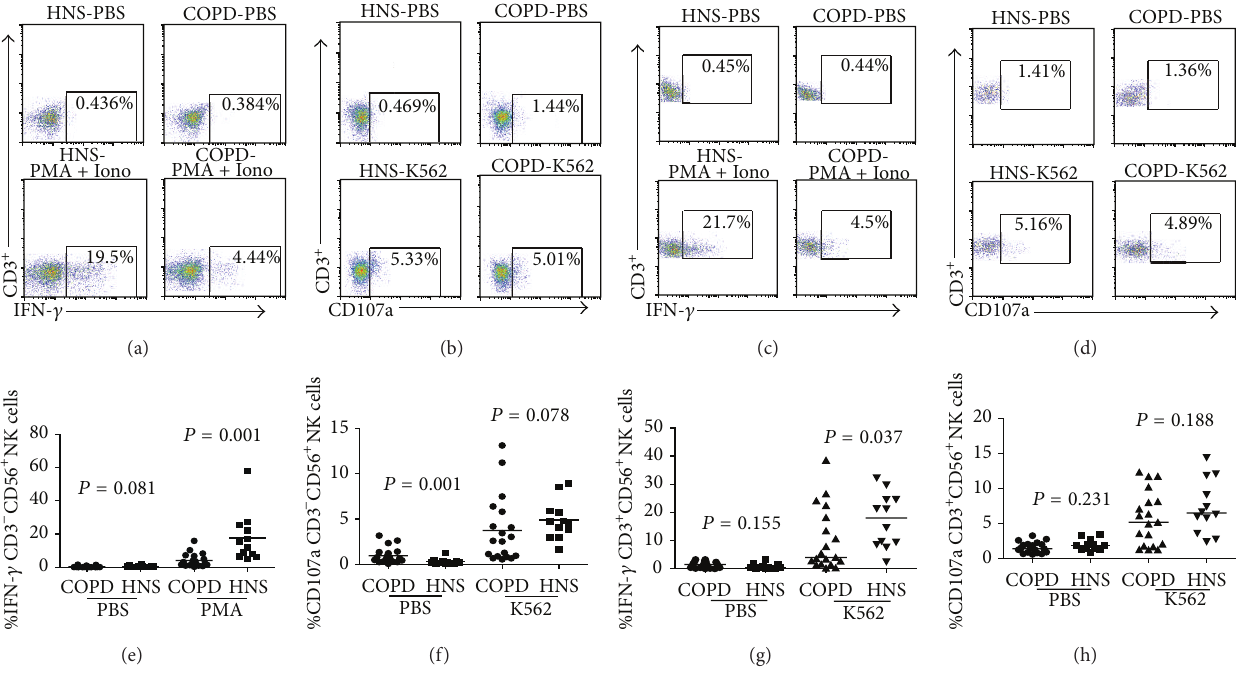
Figure 2: The frequencies of inducible IFN- 𝛾 -secreting NK cells and NKT-like cells and CD107a + NK cells and NKT-like cells in COPD patients and HNS. (a) and (b) The cells were gated initially on CD3 − CD56 + NK cells. At least 10,000 events were analyzed for each sample. Data shown are representative charts from different groups of subjects and the frequencies of IFN- 𝛾 -secreting NK cells and CD107a + NK cells in individual subjects. (c) and (d) The cells were gated initially on CD3 + CD56 + NK cells. Data shown are representative charts from different groups of subjects and the frequencies of IFN- 𝛾 -secreting NKT-like cells and CD107a + NKT-like cells in individual subjects. (e) and (f) Summarized data show the frequency of IFN- 𝛾 -secreting NK cells and CD107a + NK cells in individual subjects. (g) and (h) Summarized data show the frequency of IFN- 𝛾 -secreting NKT-like cells and CD107a + NKT-like cells in individual subjects.